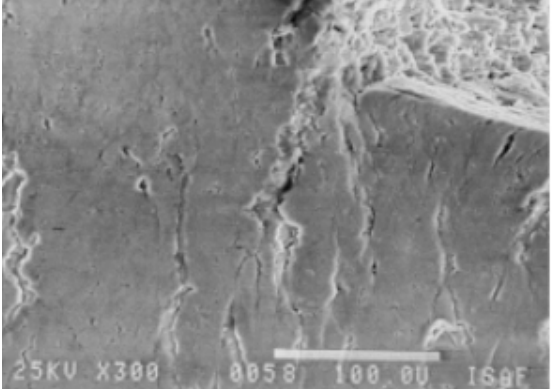
Figure 15. Results of SEM photo of the surface of the test sample, compressive tensile loading with microcracks near the fracture surface, t = 0.6%, N = 100.